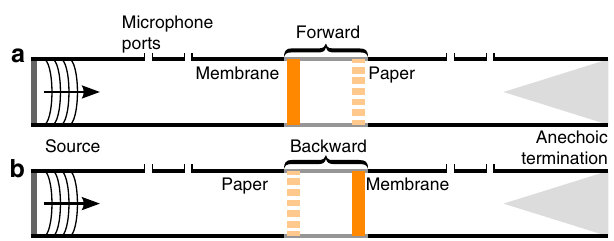
Figure 3 | Schematic of the experimental apparatus with the effective material element in the forward and backward orientations. The apparatus consists of a plane wave tube with a built-in source on one side, two microphone ports before and two microphone ports after the test section that contains the metamaterial element and an anechoic termination. The effective material element is placed in the test section in either the forward (membrane-air-paper) or backward (paper-air- membrane) orientation as indicated by a , b n ¼ 0.34 and mass density r ¼ 1,420 kg m (cid:2) 3 . Figure 2 provides a